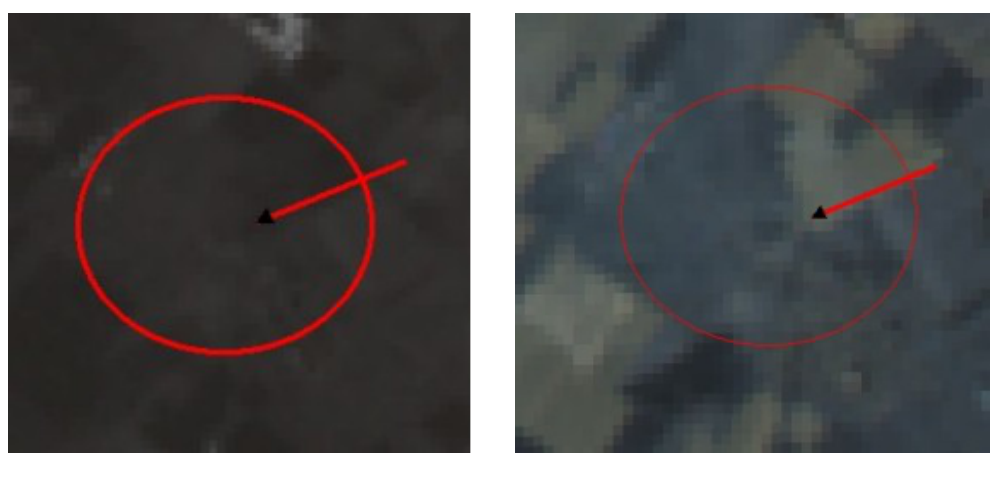
Figure 10. Appearance of a settlement RGB → 8, 9, 10 (left) Appearance of the same settlement after application of RGB1